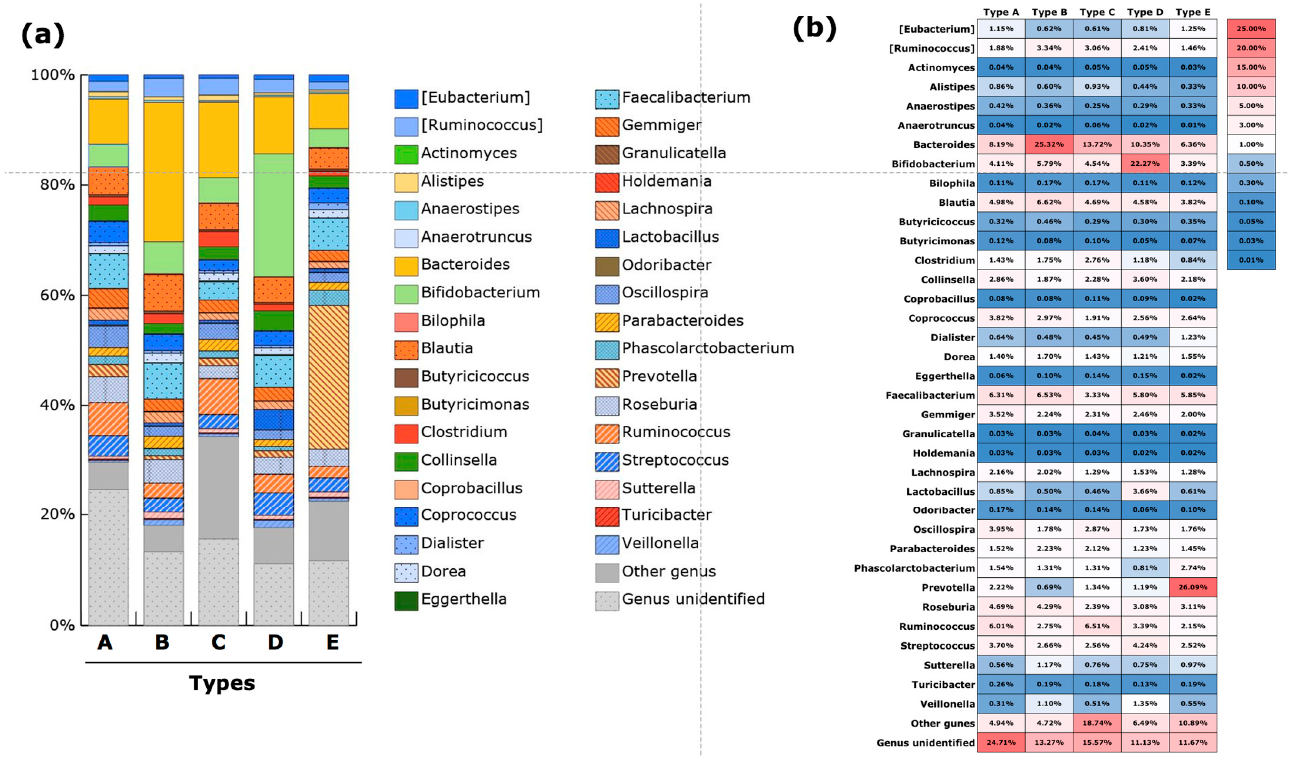
Figure 3. Taxonomic composition of the microbial communities at the genus level for five PAM- identified types. Cumulative bar charts of abundance of frequently detected genera ( a ) and a heatmap of the of mean abundance values of frequently detected genera ( b ). The frequently detected genera were comprise 36 genera, which were detected in more than 50% of the subjects.